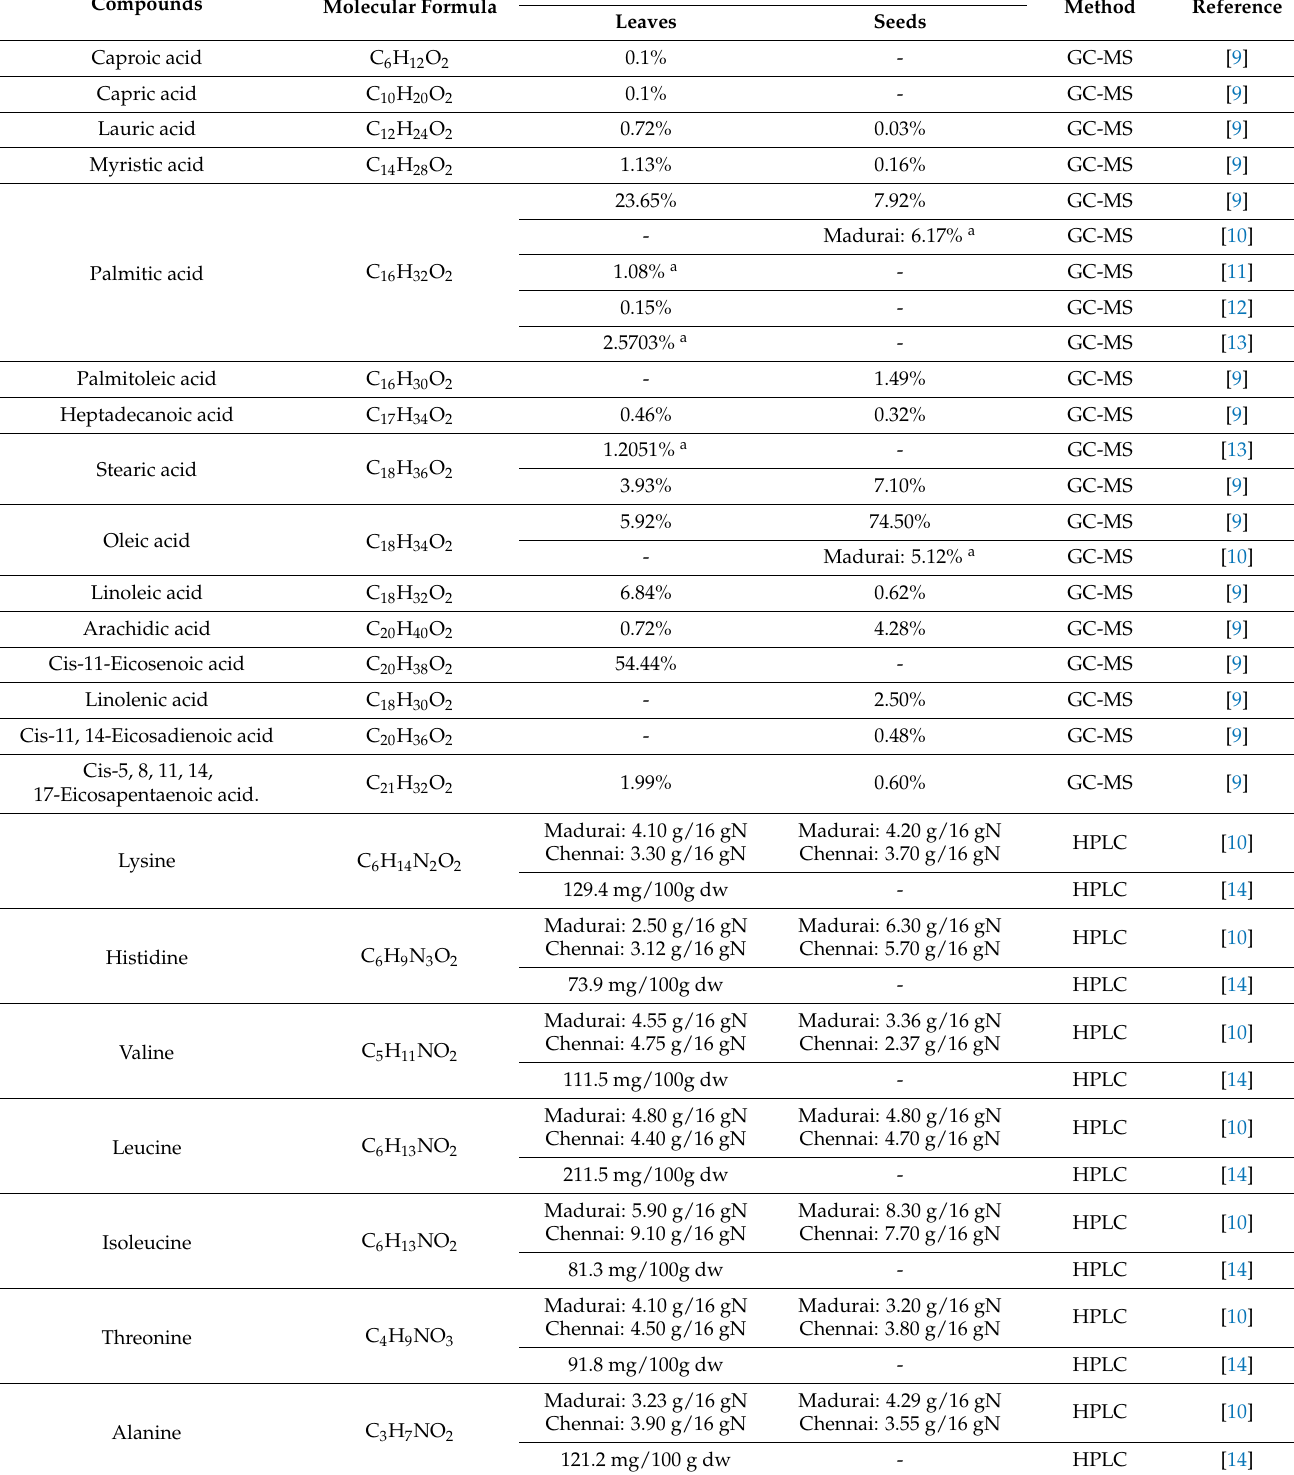
Table 1. List of compounds extracted from Moringa oleifera leaves and